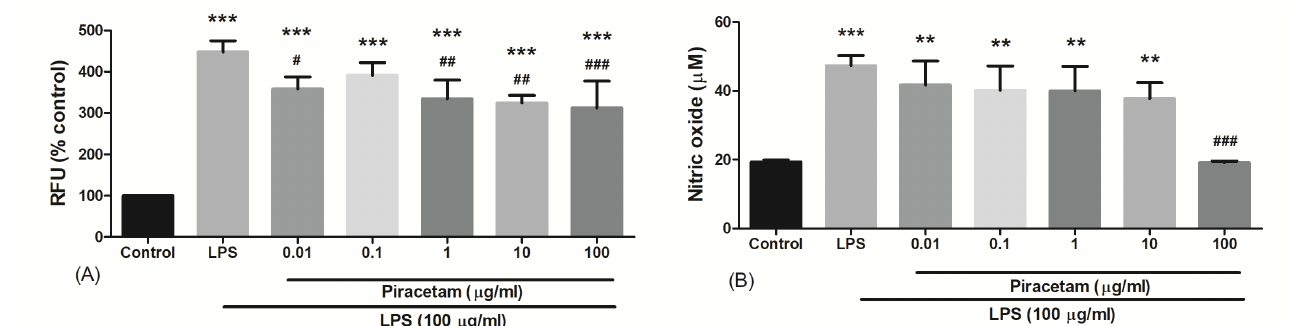
FIGURE 2 - Effect of piracetam on ROS and NO against LPS-induced in EOC-20 cells. (A) ROS level (RFU-Relative Fluorescence Units) was measured by the oxidation of DCFH-DA. (B) NO level was measured using a Griess reagent. Each bar represents the mean ± SD of three independent experiments (**P<0.01 and ***P<0.001 vs. control; # P< 0.05, ## P<0.01 and ### P<0.001 vs